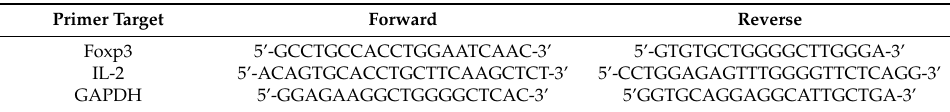
Table 1. List of primers used for